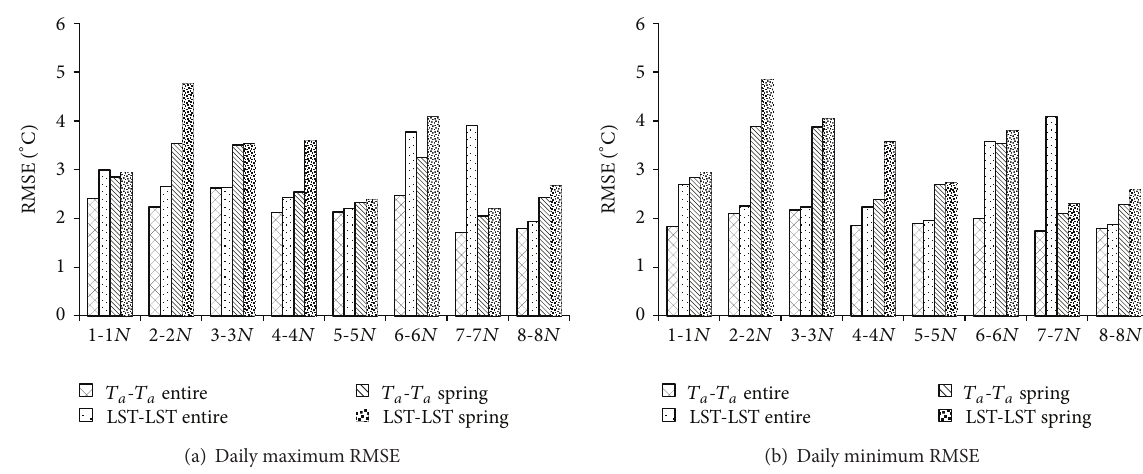
Figure 7: RMSE values of daily maximum and minimum 𝑇 𝑎 creation results for 𝑇 𝑎 - 𝑇 𝑎 and LST-LST methods. In each group of bars, from left to right are 𝑇 𝑎 - 𝑇 𝑎 (entire period), LST-LST (entire period), 𝑇 𝑎 - 𝑇 𝑎 (spring), and LST-LST (spring). Table 8: Performance of Elev 𝑇 𝑎 and New 𝑇 𝑎 scenarios in the least parameters and complete parameters settings. The least parameters settings Complete parameters Basin